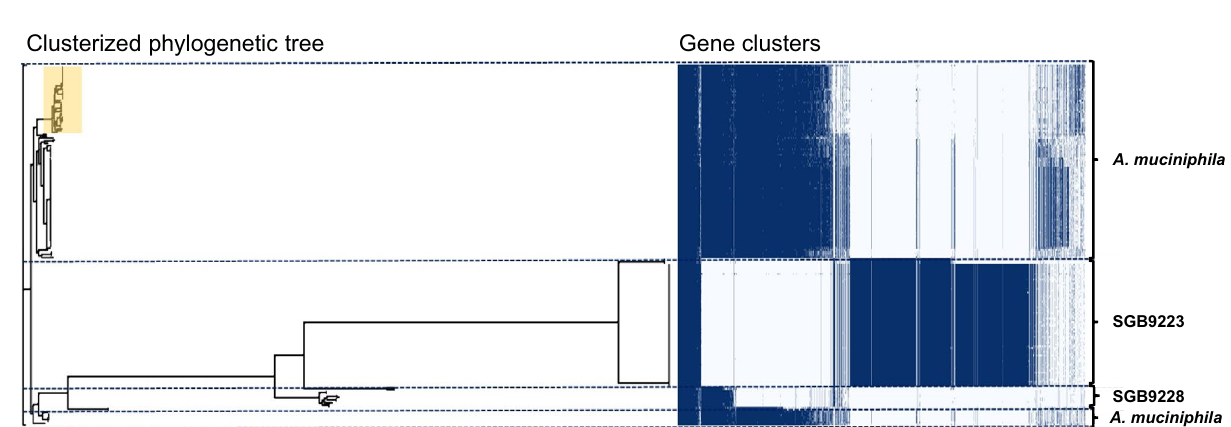
Figure 2. Phylogenetic tree of the 193 Akkermansia sp. genomes. The shell genes were used for the clusterization based on gene presence (dark blue) or absence (white). The genomes are clusterized into three groups corresponding to Akkermansia sp. SGB9228 (11 genomes), SGB9223(69 genomes), A. muciniphila (113 genomes). The yellow zone of the tree highlights the position of the newly isolated A. muciniphila strains characterized in this